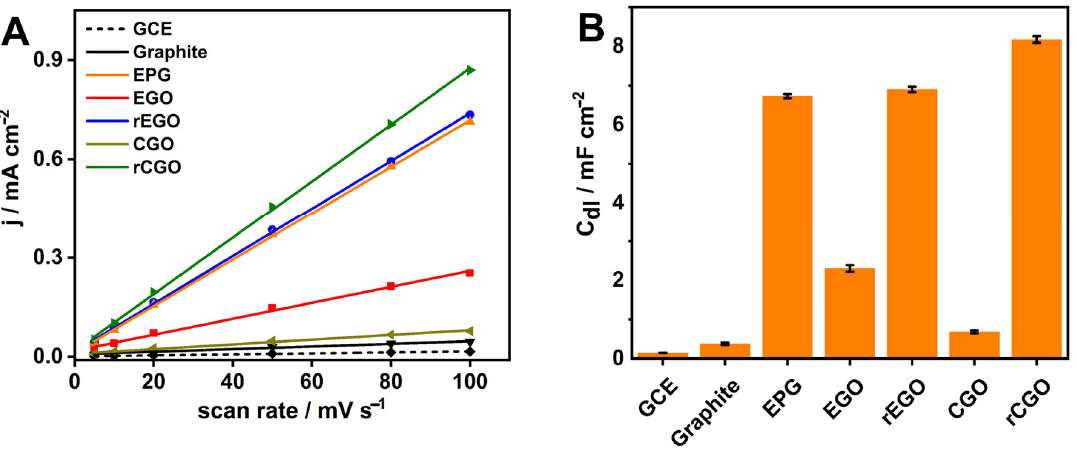
Figure 7. ( A ) Double layer capacitance determination from scan rate studies, ( B ) A bar chart of dou- ble layer capacitance values of all